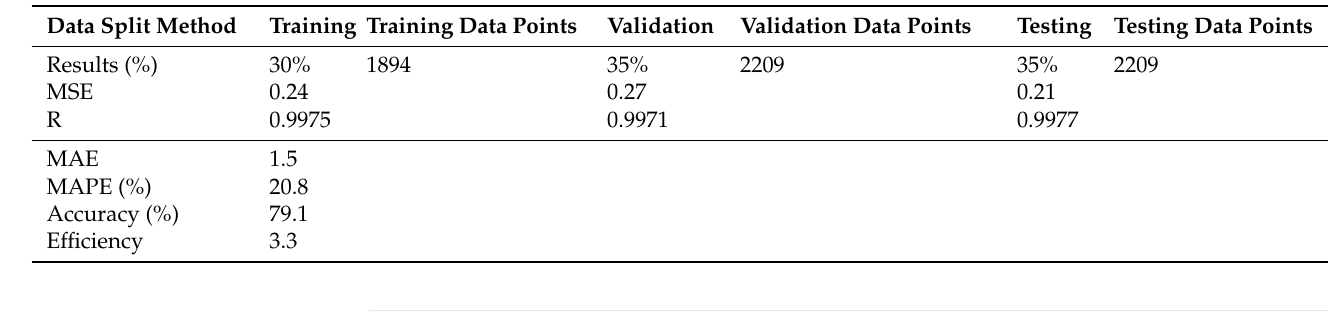
Table 5. Best performance of DLSA from Scenario 7.